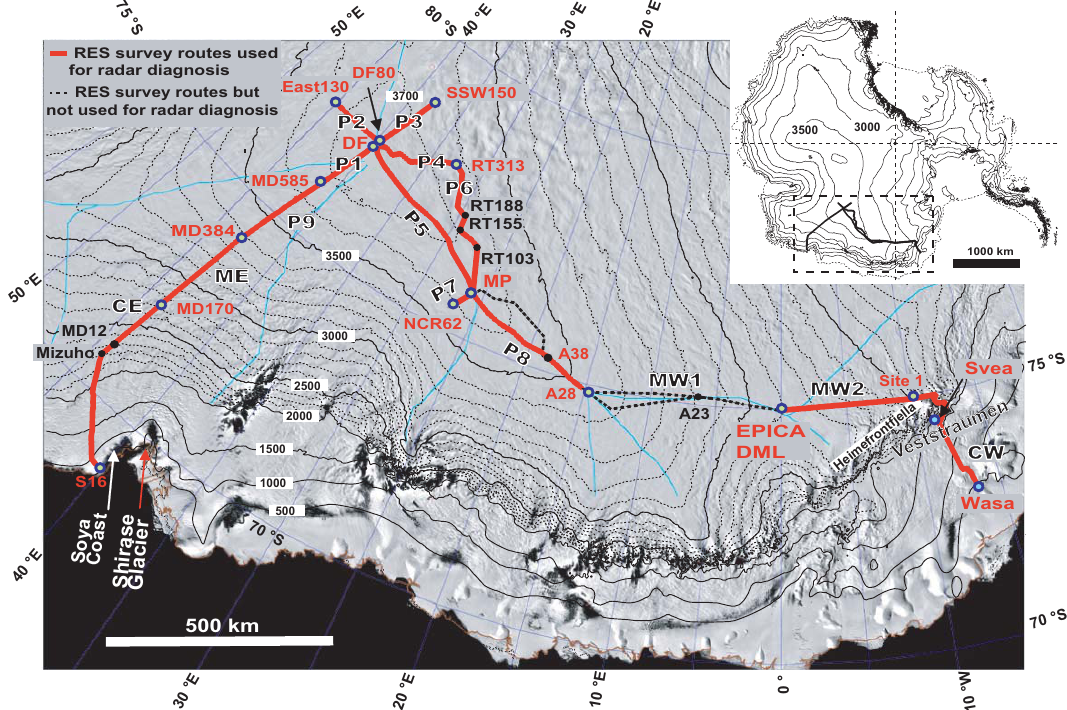
Fig. 1. Dronning Maud Land, East Antarctica. Contours show the surface elevation in metres relative to the WGS84 ellipsoid. The background satellite image is a MODIS mosaic of Antarctica (Haran et al., 2005). The red lines show the survey routes for the ground-based radar sounding discussed herein. The traces include the route of the JASE traverse (Holmlund and Fujita, 2009; Fujita et al., 2011) connecting two deep ice coring sites, namely, Dome Fuji and EPICA DML. The dotted black lines are radar survey routes not used for radar diagnosis in this paper. The locations of major sites along the routes are listed in the Supplementary information as Table A. Labelled legs are listed in Table 2. The thin blue traces represent ice divides that separate drainage basins.